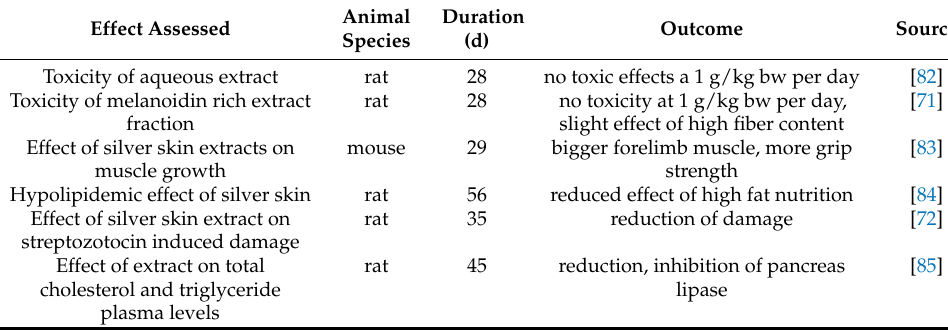
Table 7. Overview of chronic animal